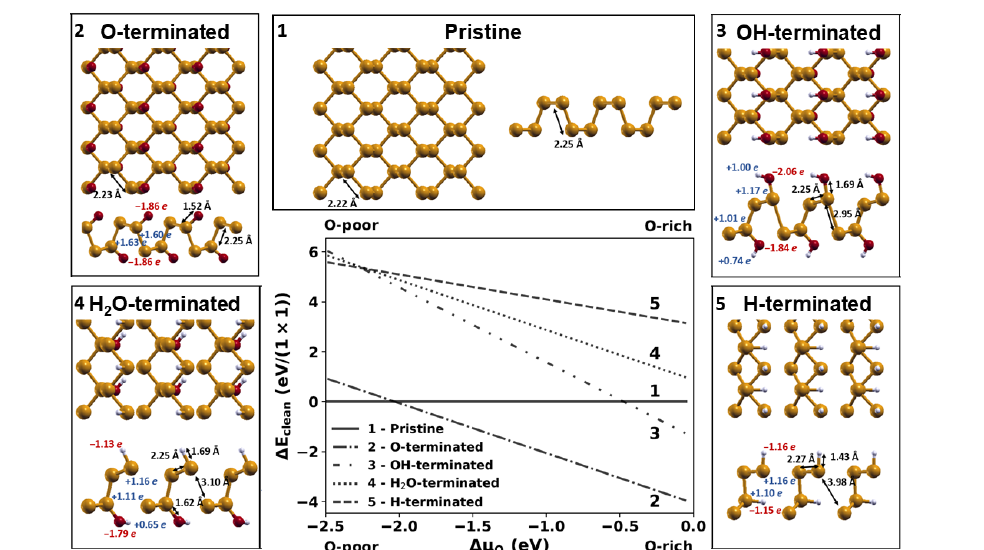
Figure 1. Phase diagram of phosphorene with different terminations at 50% coverage. In the surrounding panels representing the optimized structures, the most relevant bond lengths and partial charges are indicated. Yellow, red, and light-gray colors are used for phosphorous, oxygen, and hydrogen atoms,